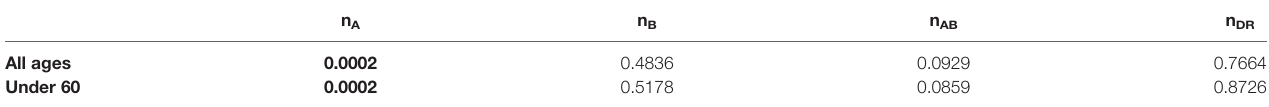
TABLE 2 | p-values (p < 0.05 in bold) from the two two-tailed Wilcoxon test between patients and controls of all ages or those under 60 years old on numbers of SARS-CoV-2-derived peptides predicted as weak binders of HLA molecules (HLA-A: n A ; HLA-B: n B ; HLA-A and HLA-B: n AB ; HLA-DR: n DR ) according to %Rank. n A n B n AB n